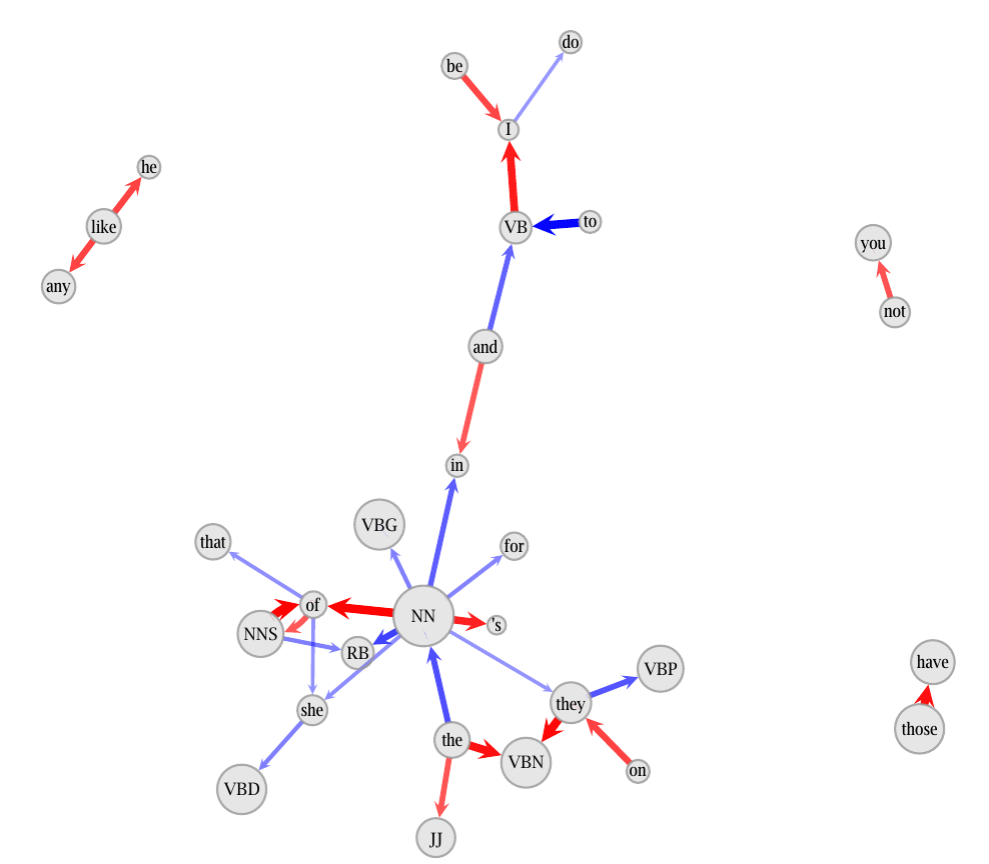
Figure 5. Comparative bigram graph for Bloom’s and Stephen’s thoughts. Blue arrows indicate over- representation in Bloom’s thoughts, red arrows indicate over-representation in Stephen’s